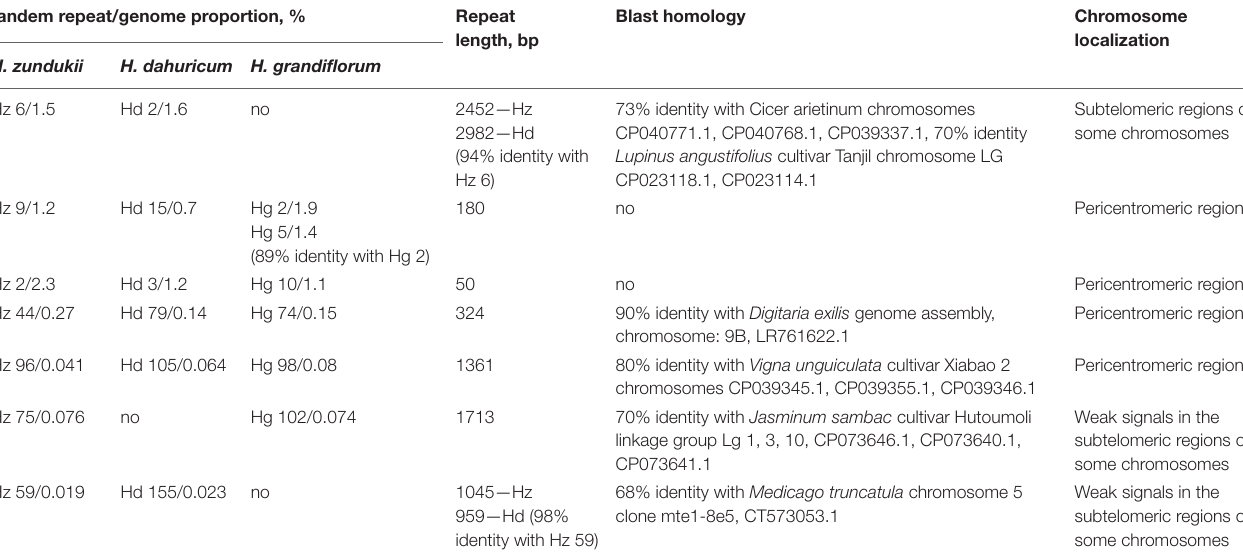
TABLE 2 | Homology* of tandem repeats identified in genomes of H. grandiflorum , H. dahuricum, and H. zundukii and FISH-based patterns of their chromosomal distributions. Tandem repeat/genome proportion, %